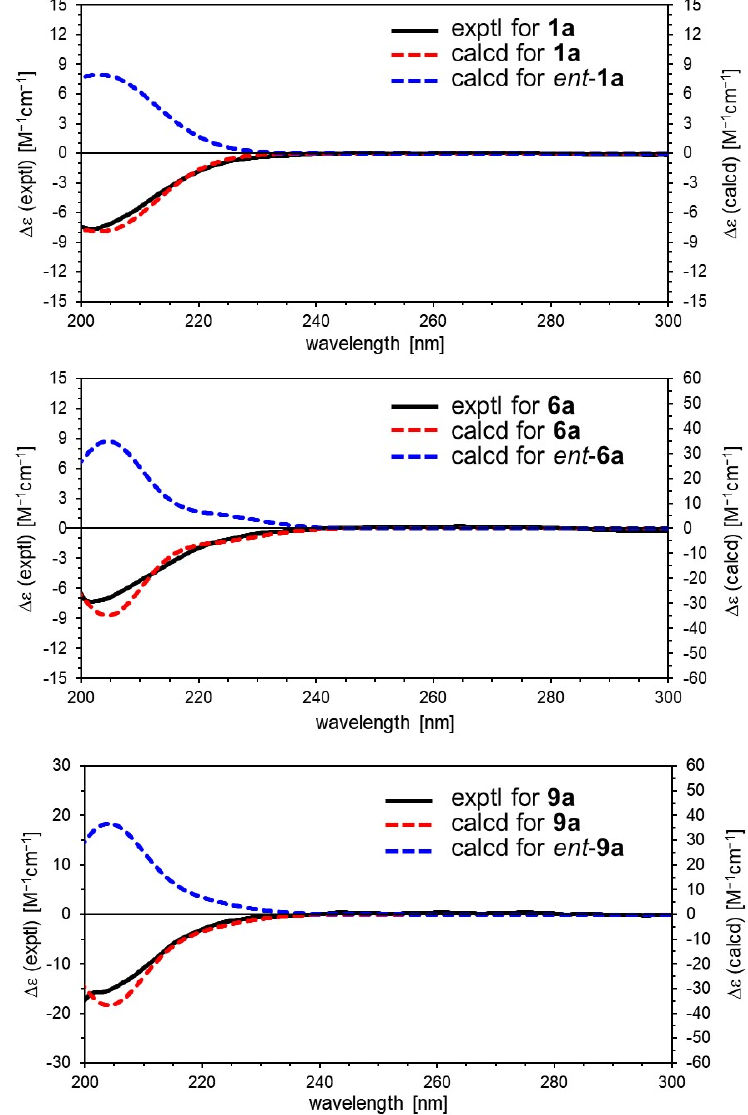
Figure 4. Experimental and calculated ECD spectra for 1a , 6a , and 9a . Table 2. 13 C (150 MHz) and 1 H (600 MHz) NMR data for valerianairidoid IV ( 6 ), its aglycone 6a , and Valerianairidoid VI ( 9 ) was isolated as an amorphous solid with a negative optical valerianairidoid V ( 7 rotation ([ α ] 25D − 15.4 in MeOH), and its molecular formula (C 32 H 50 O 18 ) was determined by HRESIMS and 13 C NMR spectroscopy. The 1 H and 13 C NMR (CD 3 OD) spectra suggest that 9 contains an iridoid moiety, a gentiobiose moiety, and two isovaleryl moieties (Ta- ble 3); their positions were determined by DQF COSY and HMBC NMR spectroscopy (Figure 2), and the relative stereochemistry of 9 was determined by NOESY spectroscopy (Figure 3). Aglycone 9a was obtained by the enzymatic hydrolysis of 9 using cellulase and identified as the aglycone of kanokoside A [18]; however, its absolute configuration was not determined previously. The absolute configuration of 9 was further established as 1 S ,5 S ,6 S ,7 S ,8 R ,9 S by comparing the experimental and calculated ECD spectra of 9a . We conclude that the chemical structure of valerianairidoid VI ( 9 ) is as shown in Figure 1.